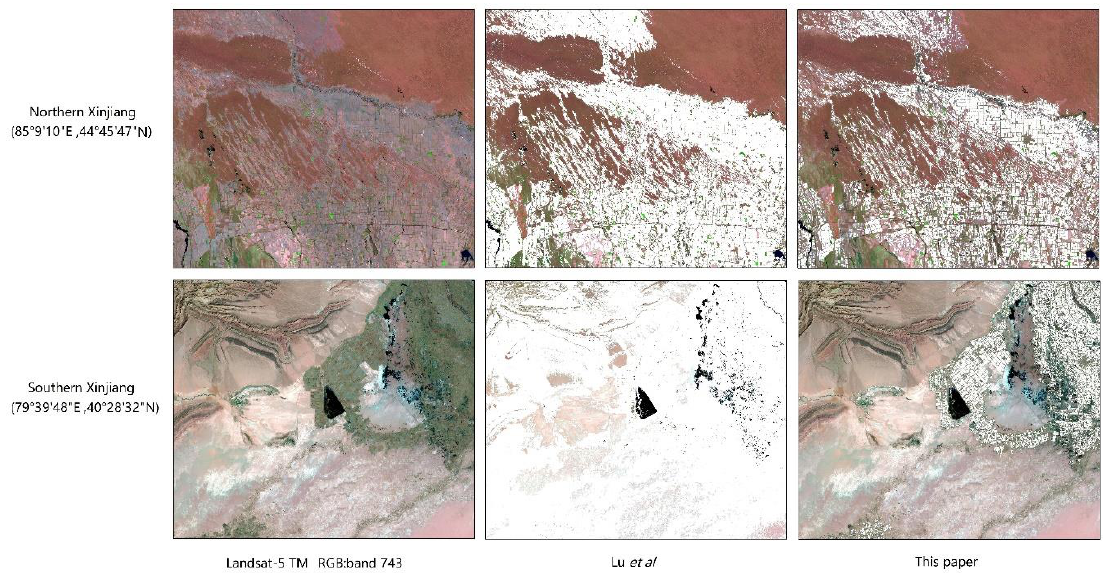
Figure 10. A visual comparison of different results (shown in white color) from the different algorithms overlaid on the false color composite of Landsat-5 TM (R = SWIR 2, G = NIR, B = Blue).